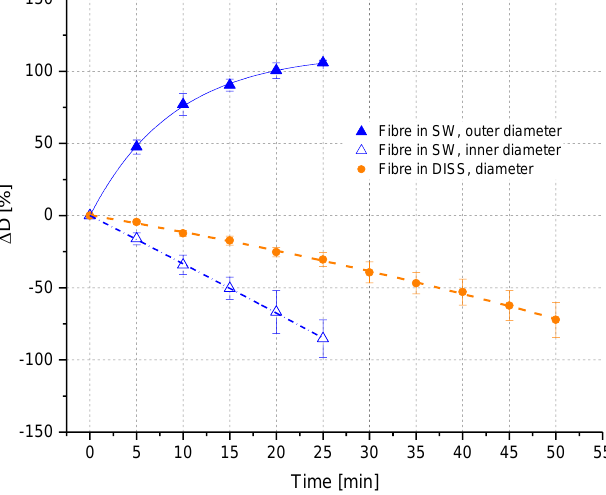
Polymers 2018 , 10 , x Figure 6. Fibre diameter changes (ΔD in %) depending on time in SW and DISS in in situ Figure 6. Fibre diameter changes ( ∆ D in %) depending on time in SW and DISS in in situ experiments. experiments.